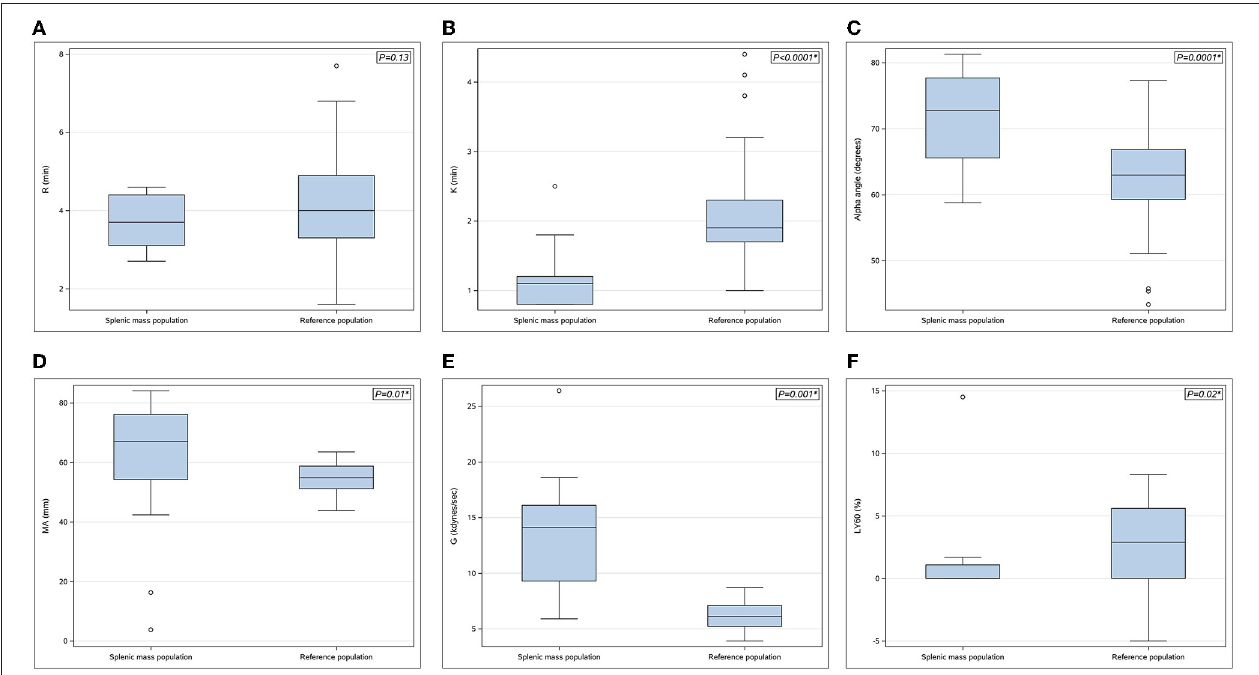
FIGURE 1 | (A–F) Boxplots of thromboelastography parameters in dogs with splenic masses ( n = 15) compared with the reference population ( n = 75). (A) R-time (min), (B) K-time (min), (C) Alpha angle (degrees), (D) Maximum amplitude (MA) (mm), (E) G-value (kdynes/sec), (F) % lysis at 60min (LY60%) (%). Each box represents the interquartile range (25th to 75th percentile) with the horizontal line within each box corresponding to the median value for each parameter. Whiskers represent the upper and lower limits of the range. Open circles represent outlier values. P -values are shown in the upper right-hand corner with statistical significance denoted